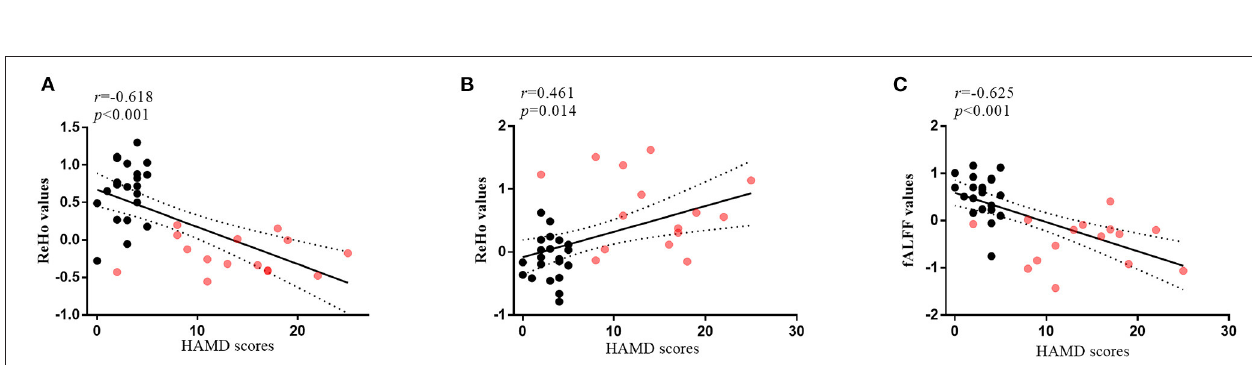
Frontiers in Neurology |